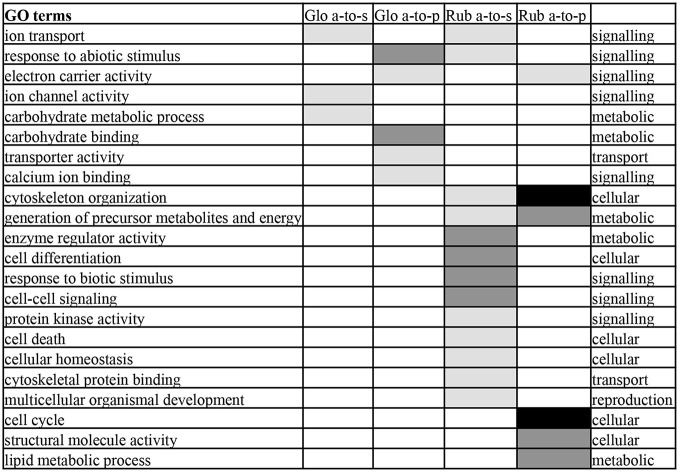
Enriched Gene Ontology (GO) terms of the categories biological process and molecular function in antisense-to-protein (a-to-p) and antisense-to-sense (a-to-s) transcripts in
C. glomerata
(Glo) and
C. rubecula
(Rub). GO terms enriched with P < 0.001 are indicated in black, with 0.01 < P < 0.001 in dark gray, 0.05 < P < 0.01 in light gray.